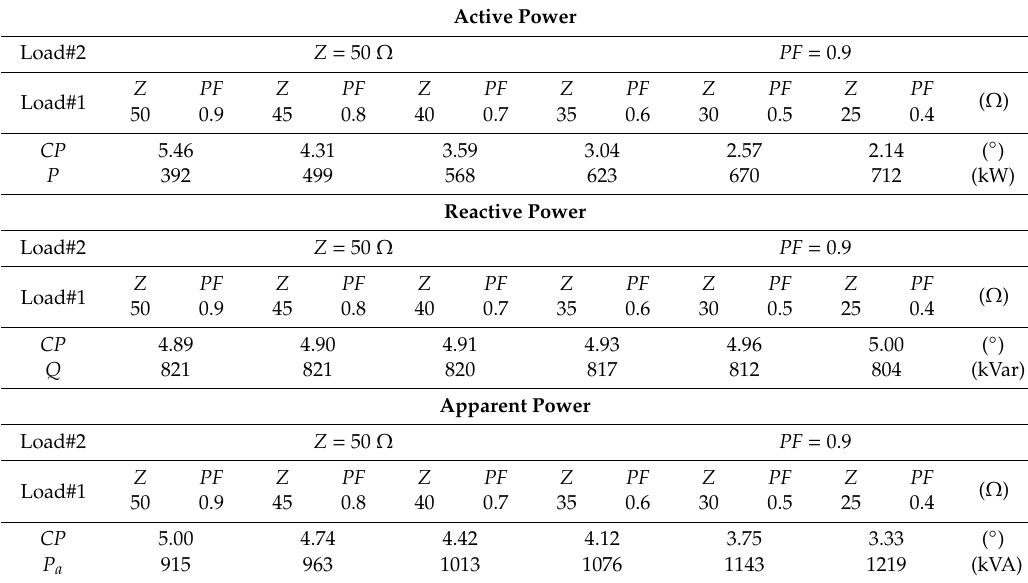
Figure 6. APC capacity according to load impedance and power factor change. ( a ) Active power; ( b ) reactive power; ( c ) apparent power. Table 3. APC capacity according to load impedance and power factor change.